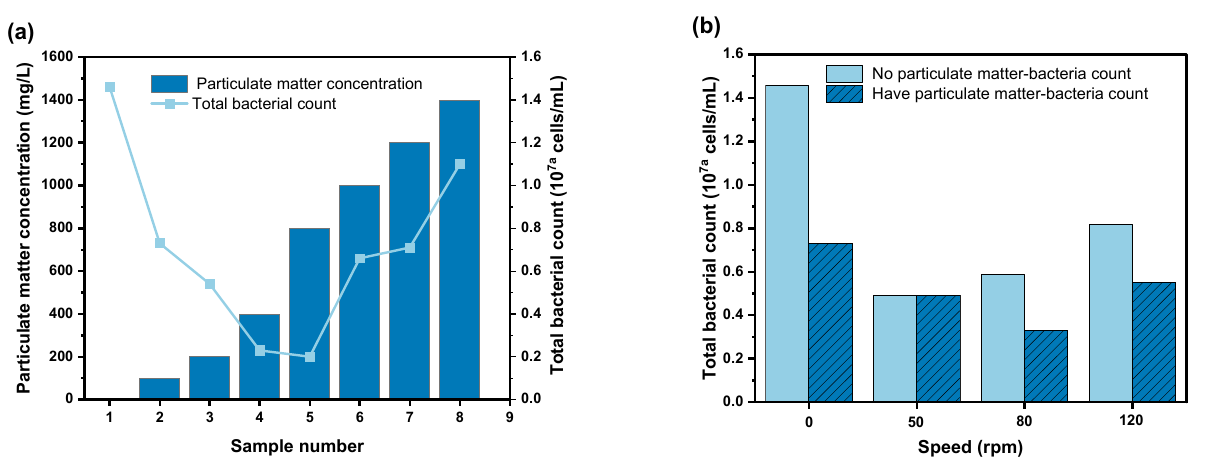
Figure 2. Effect of particulate matter content ( a ) and hydraulic conditions ( b ) on biofilm microbial biomass.